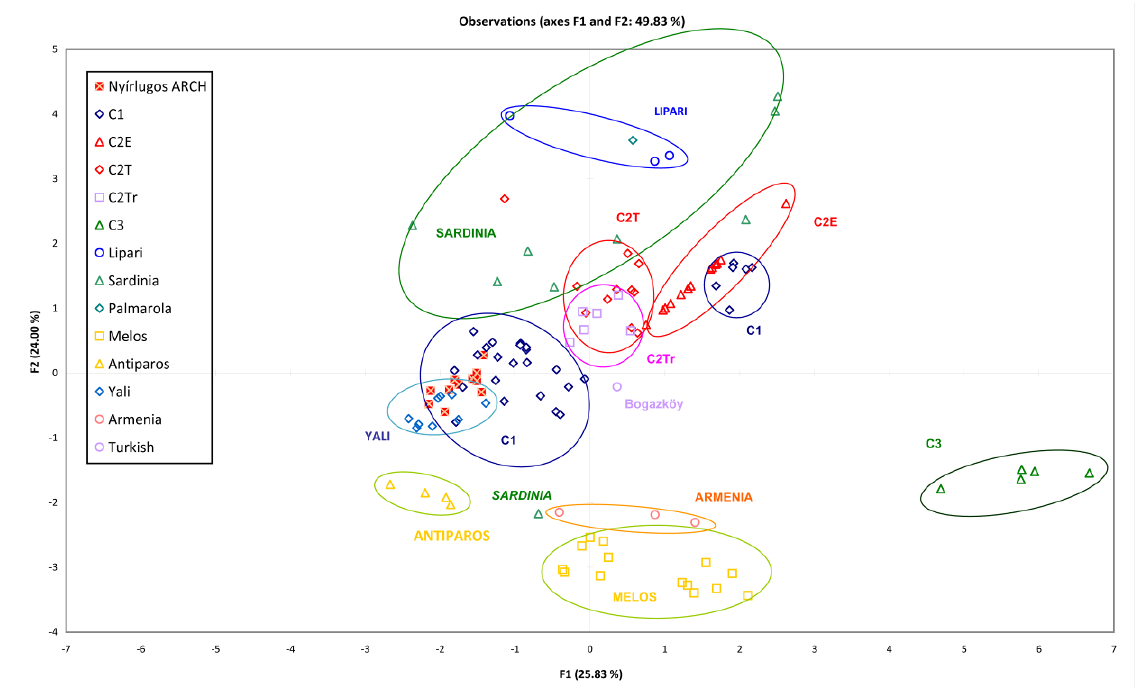
Figure 7. Separation of obsidian source regions on the basis of Factors 1 and 2 of Principal Component Analysis of geochemical data, plotting the Nyírlugos hoard on the graph.